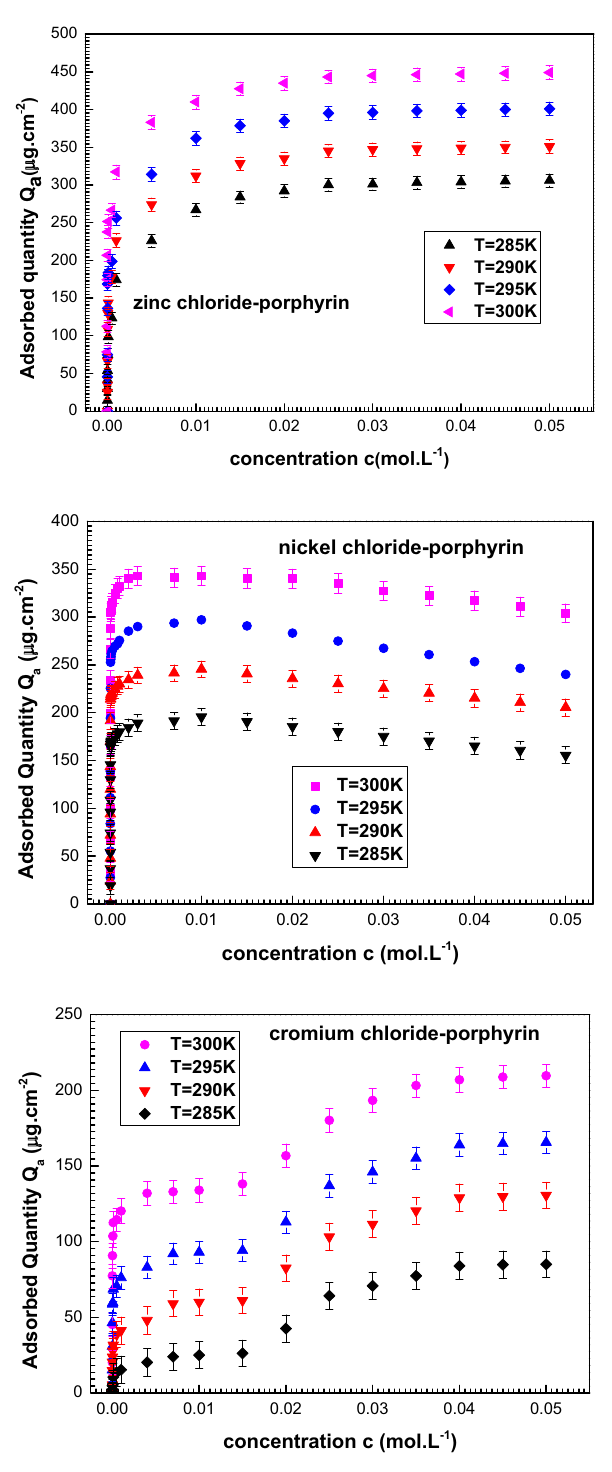
Figure 2. Experimental adsorption isotherms zinc chloride, nickel chloride and chromium chloride on 5,10,15,20-tetrakis(4-methylphenyl) porphyrin given at four temperatures (285–300